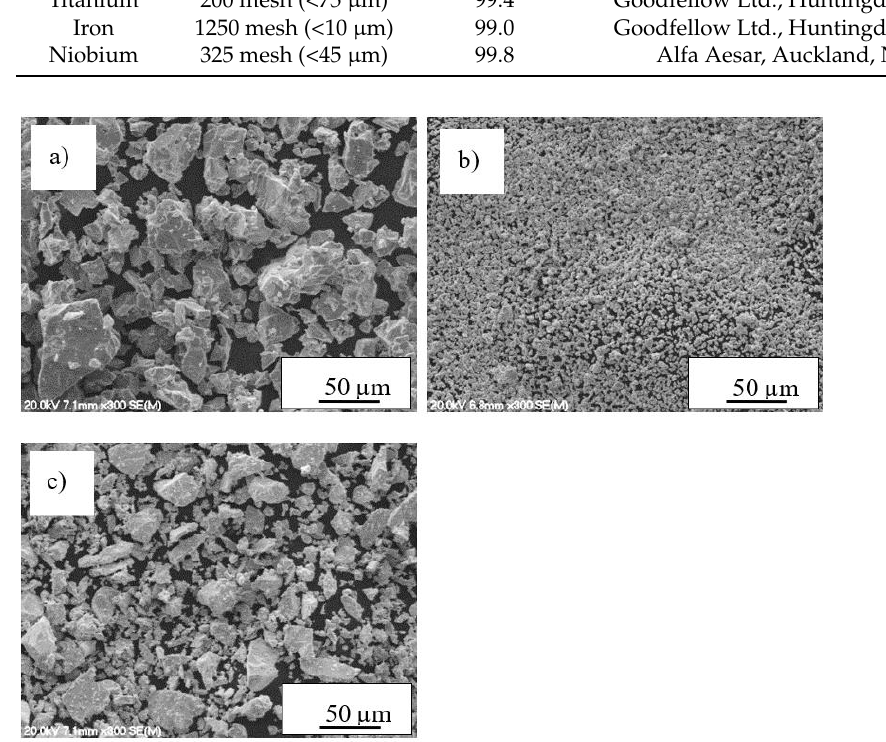
Table 1. Characteristics of the elemental powders used in this study as per supplier’s specifications. Element